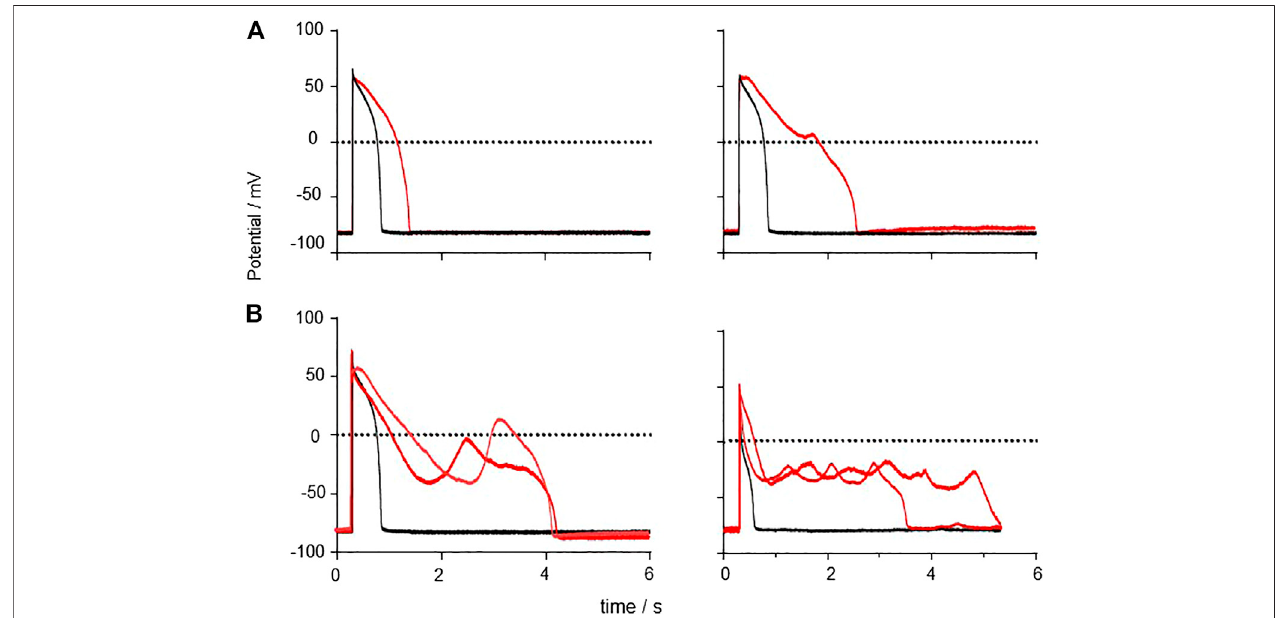
FIGURE 11 | Generation of EADs by CO Examples of responses to CO, APs and EADs from four different cells. (A) action potential prolongation (B) initiation of a failed EAD around V (cid:1) 0 mV (C) initiation of EAD from v ∼ 50 mV (D) multiple EADs/oscillations.